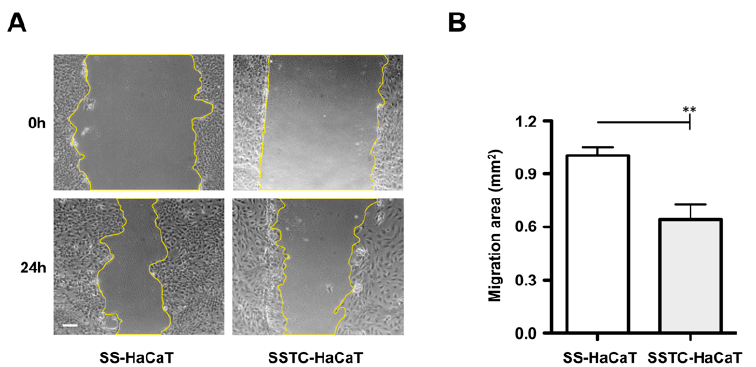
Figure 1. HaCaT cells persistently exposed to TGF- β show decreased migratory capacity. ( A ) Pictures representative of the migratory performance of SS-HaCaT and SSTC-HaCaT monolayers when challenged with epidermal continuity disruption. ( B ) Quantification of the migratory performance of SS-HaCaT and SSTC-HaCaT in regard to the initial gap area. Replicates from three independent experiments were analyzed. Shown data represent mean ± SEM. Asterisks denote statistically significant differences (** p < 0.005). The scale bar equals 100 µ